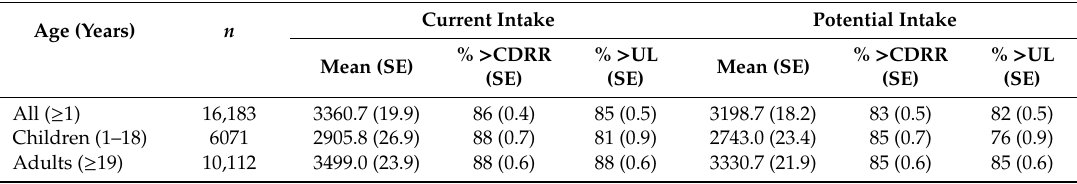
Table 3. Estimated and potential means usual sodium intake (in milligrams) from dietary sources